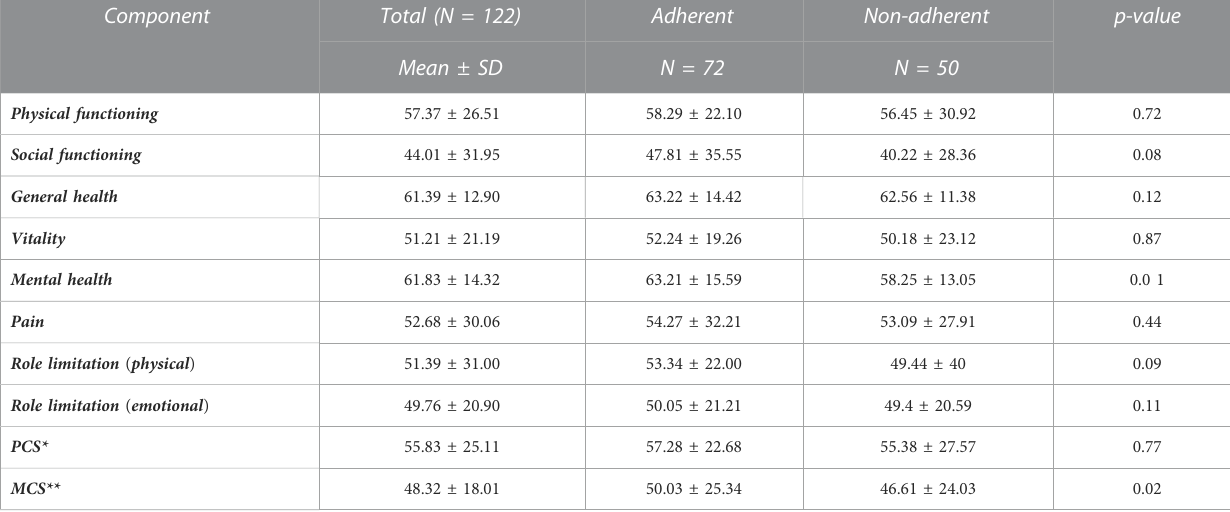
TABLE 3 Different components of quality of life between adherent and non-adherent liver transplant recipients (N =